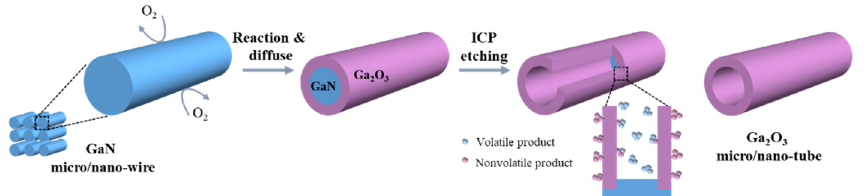
Figure 2. Schematic illustration of the formation process of β -Ga 2 O 3 micro-/nanotube depicted as a selective etching between GaN and β -Ga 2 O 3 .